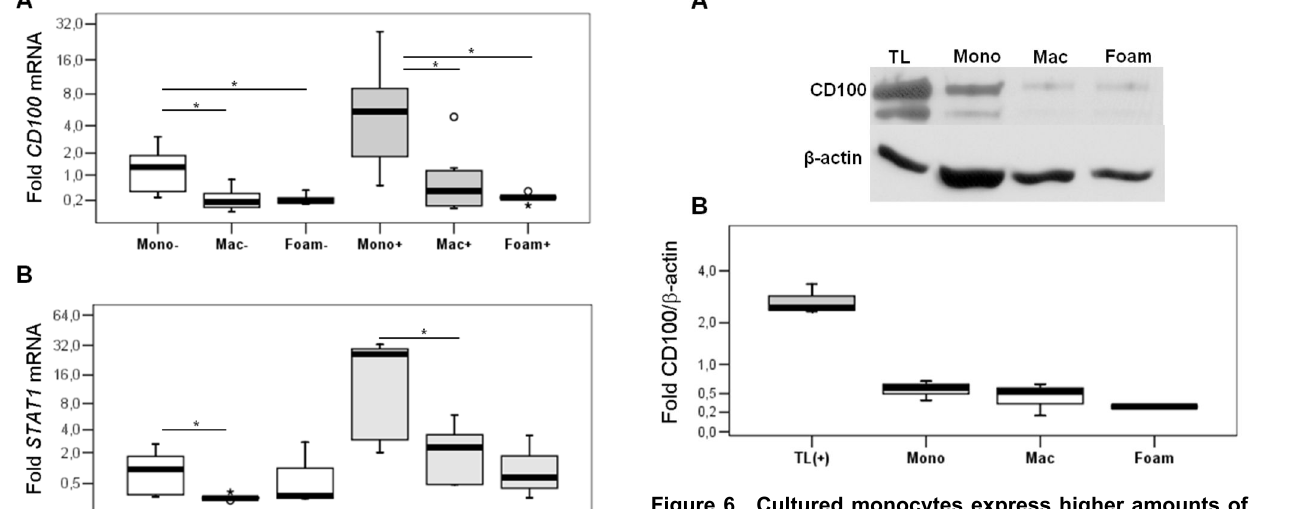
Figure 6. Cultured monocytes express higher amounts of CD100 protein than in vitro differentiated macrophages and foam cells. CD100 and β-actin protein expression was evaluated in activated T lymphocytes (TL – positive control) and PB monocytes (Mono), macrophages (Mac) and foam cells (Foam) A. Western blot showing CD100 and β-actin bands B. Densitometry of CD100 (sum of 120 and 150kDa bands) and β- actin protein bands, showing CD100/β-actin. Mean ± SD of 3 independent experiments.